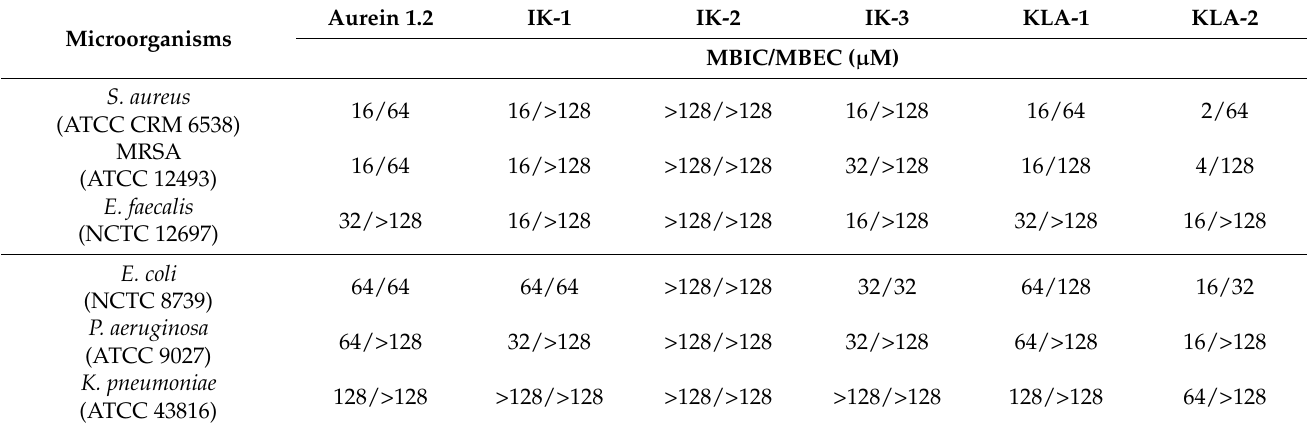
Table 3. The MBIC and MBEC values of all tested